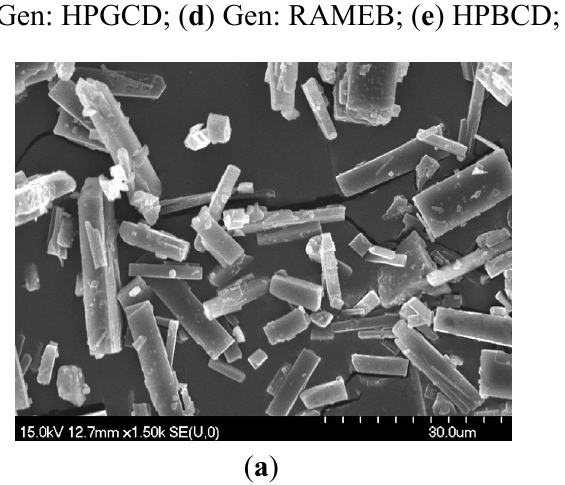
Figure 4. Scanning electron microscopy (SEM) assay for: ( a ) Gen; ( b ) Gen: